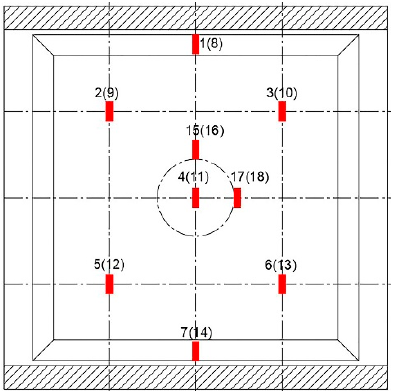
Figure 3. Strain arrangement on both sides of specimens.